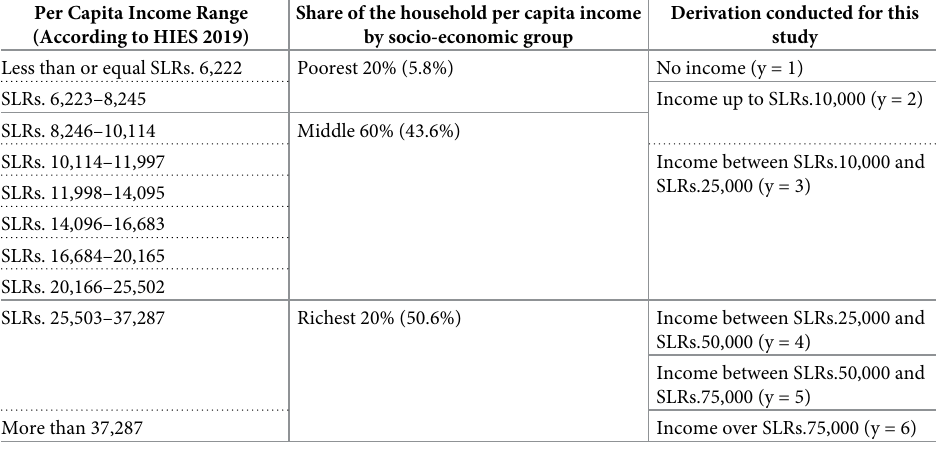
Table 1. Definitions of the income levels according to HIES–